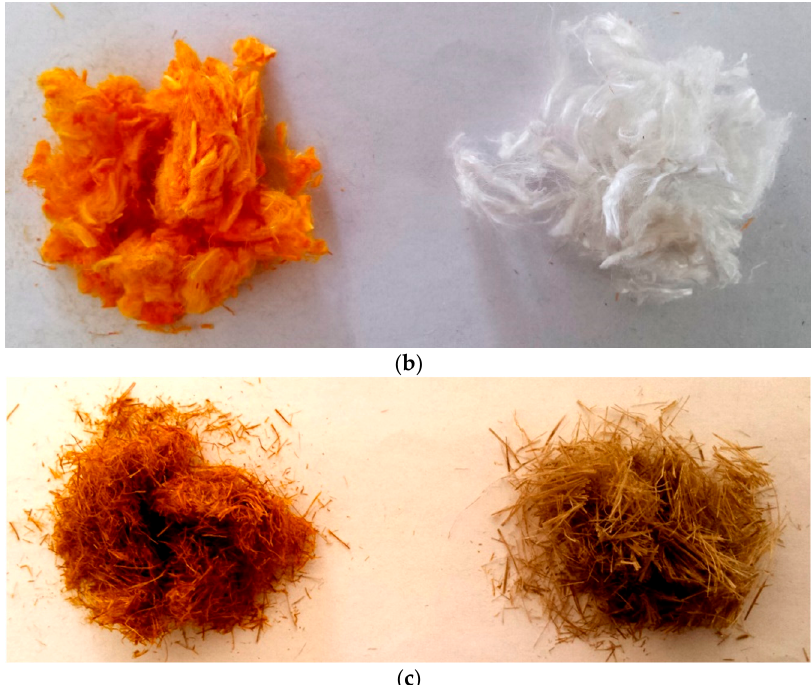
Figure 3. Photos of fibers before (right column) and after (left column) BY37 adsorption for ( a ) kenaf, ( b ) ramie, and ( c ) flax.